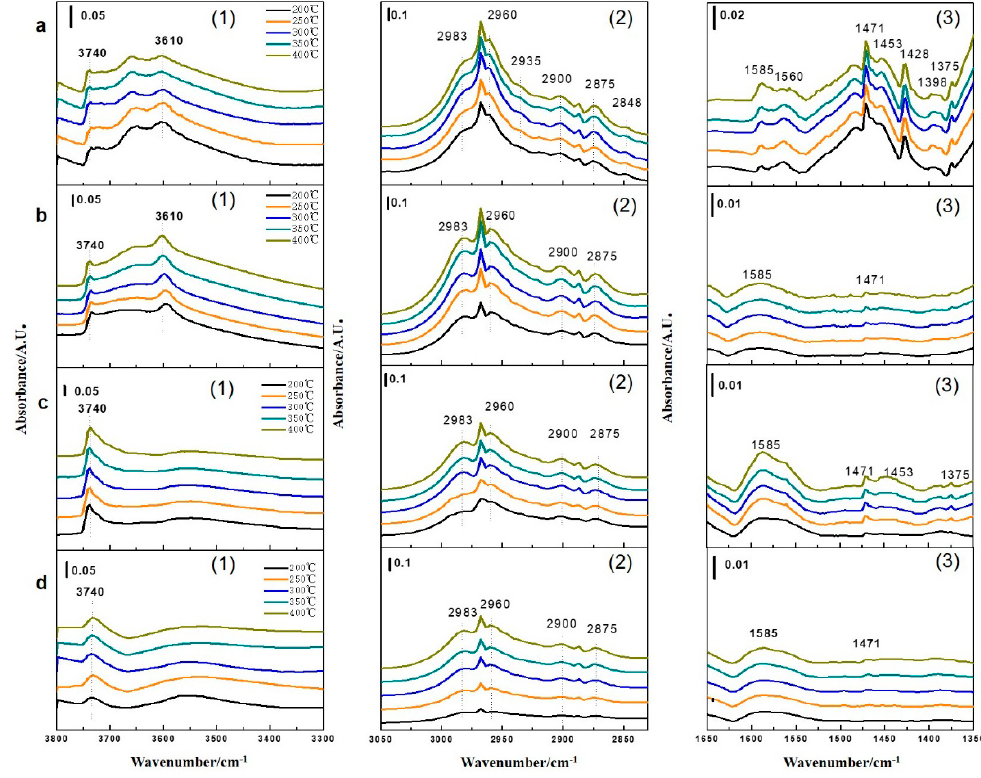
The operando DB-FT-IR spectra of propane transformation over ( a ) ZnSnPt /